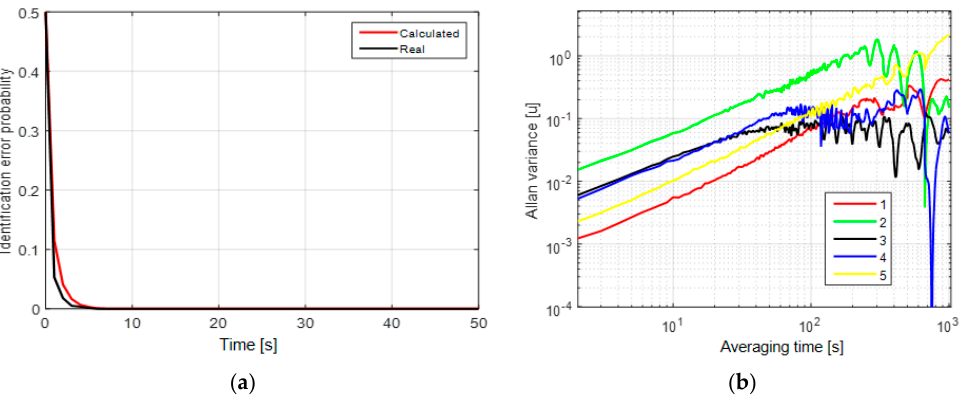
Figure 1. ( a ) Unconditional probability of the identification error without the white-noise component; ( b ) Allan variances for the random walk with σ w = 0.04 u (1—red), σ w = 0.15 u (2—green) and the first-order Markovian process with τ = 1 min, σ m = 0.5 u (3—black), τ = 5 min, σ m = 1 u (4—blue), = 1.5 u (5—yellow). τ = 25 min, σ m